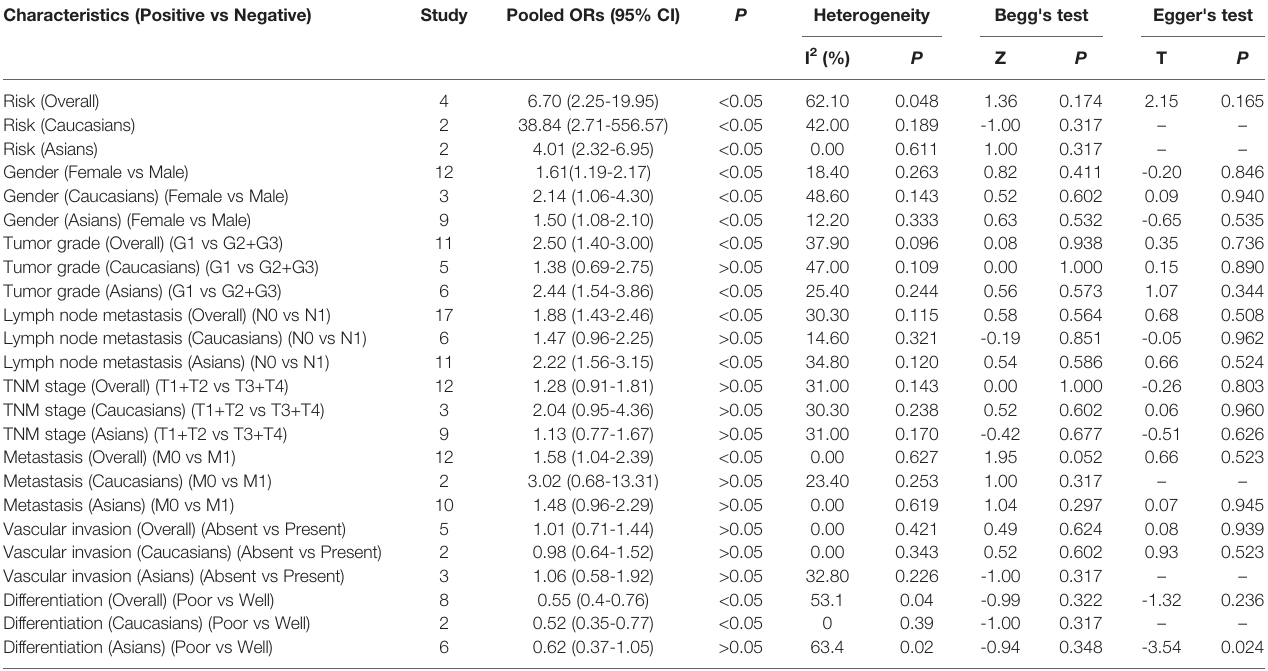
TABLE 4 | Meta-analysis result of pooled ORs for clinical features of pancreatic cancer patients. Characteristics (Positive vs